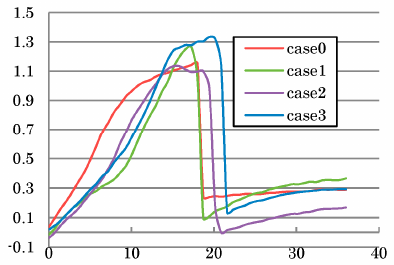
Figure 6. Lift coefficients at Re = 1.0 × 10 5 = 1.0.